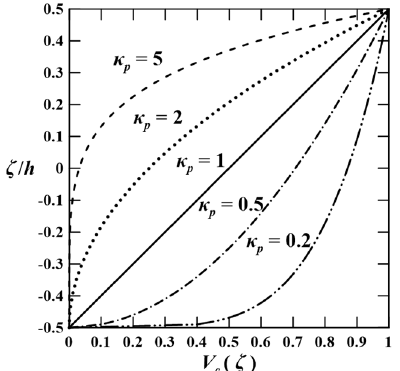
Figure 2. Through-thickness distributions of the volume fraction of the FGDC shell for di ff erent values of material–property gradient indices κ p of the power–law model.